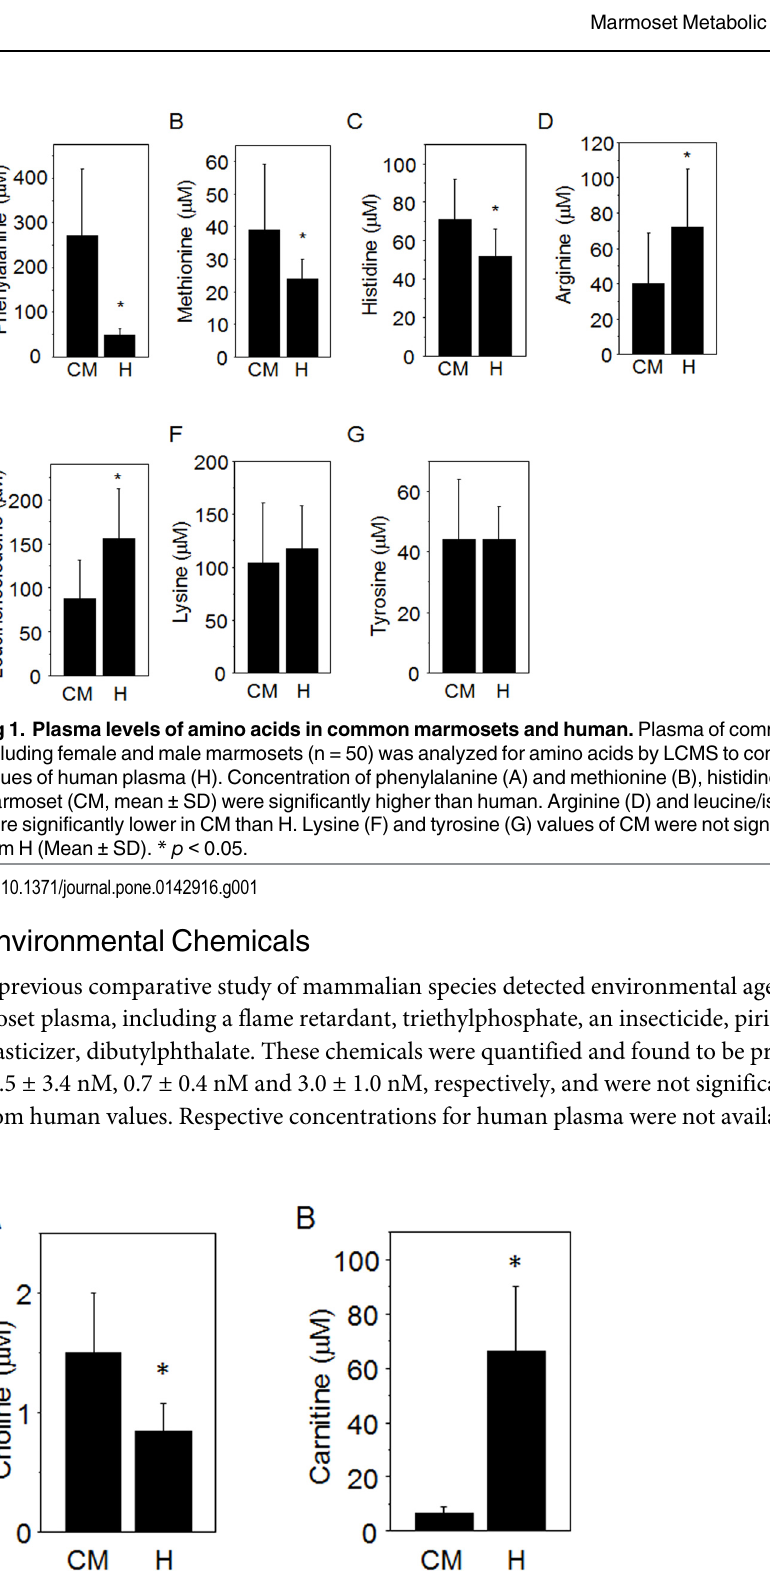
Fig 2. Choline and carnitine metabolites were lower in common marmoset than human. Using the same method described in Fig 1, choline (A) and carnitine (B) in lipid category of common marmoset (CM) were quantified and compared with human (H). Bar graphs show Mean ± SD. * p <